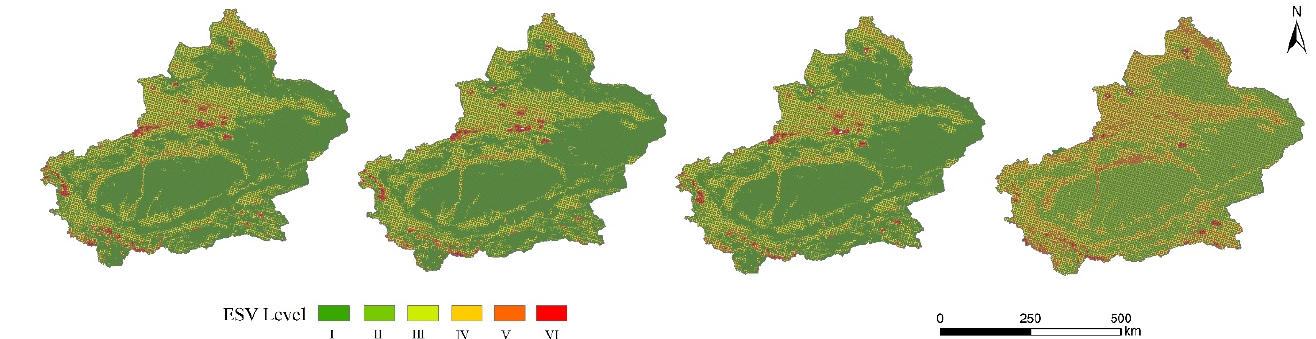
Figure 3. Spatial distribution characteristics of the ESV in Xinjiang from 1990 to 2020.